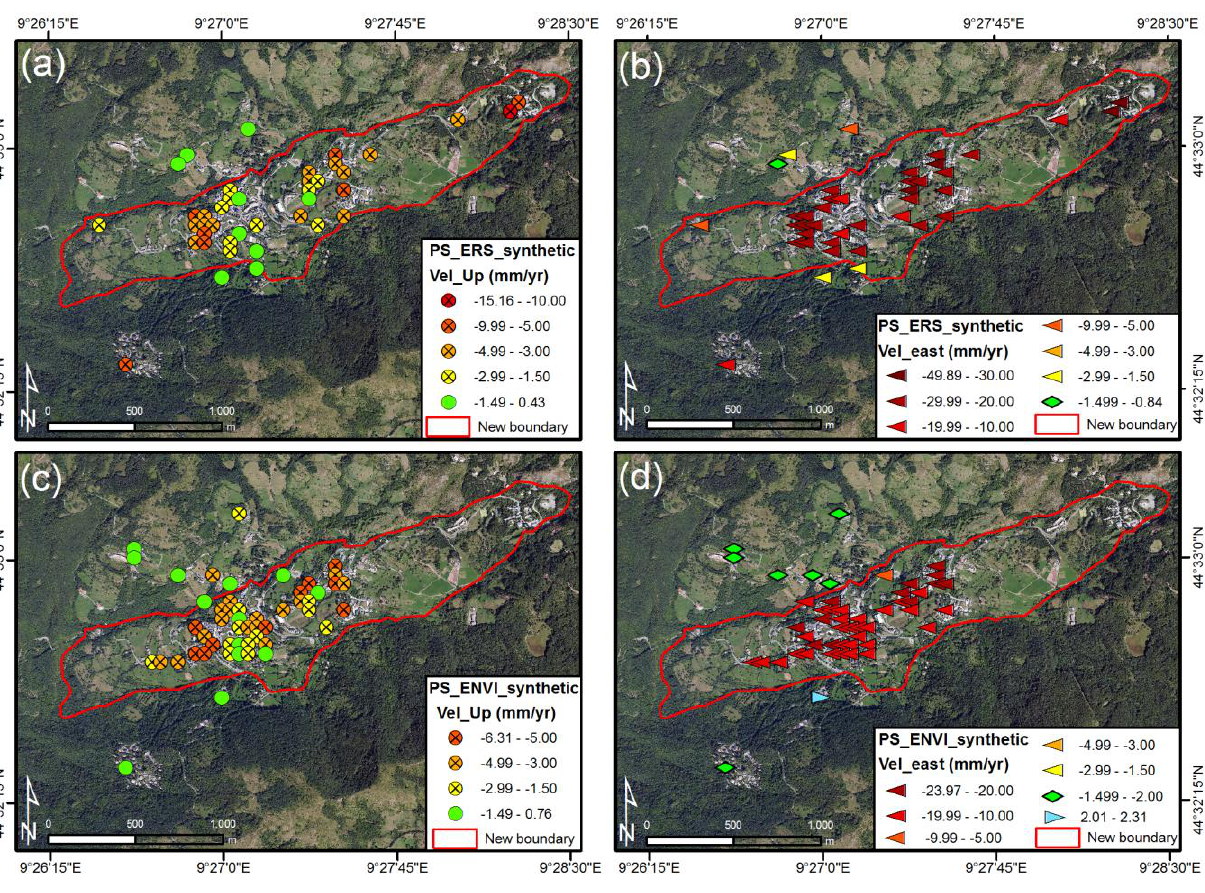
Figure 6. ( a ) ERS vertical and ( b ) horizontal (E-W) component; ( c ) ENVISAT vertical and ( d ) horizontal (E-W)